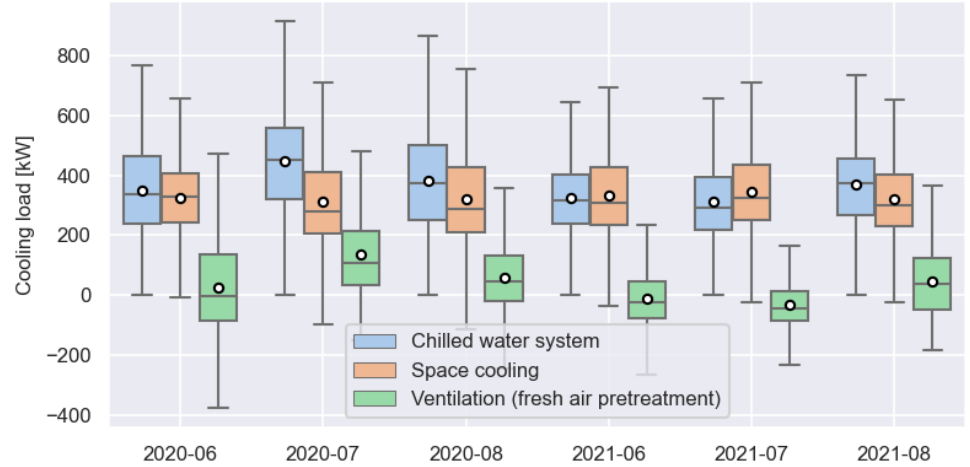
Figure 4. Cooling load overview for the case study building: the chilled water system bars show the overall cooling load incurred in the plants; the bars labelled space cooling and ventilation represent the amount of cooling load used for room conditioning and fresh air pretreatment.